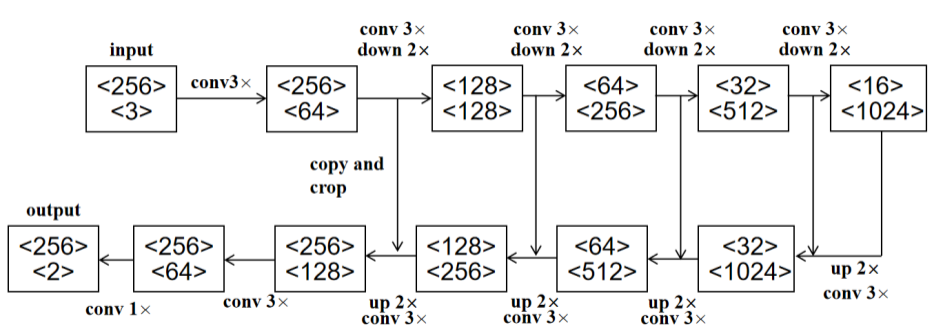
Figure 12. Selection and arrangement of successive convolutional layers in U-Net. The first number in each box represents the resolution of the feature map, and the second number represents the number of feature map channels.